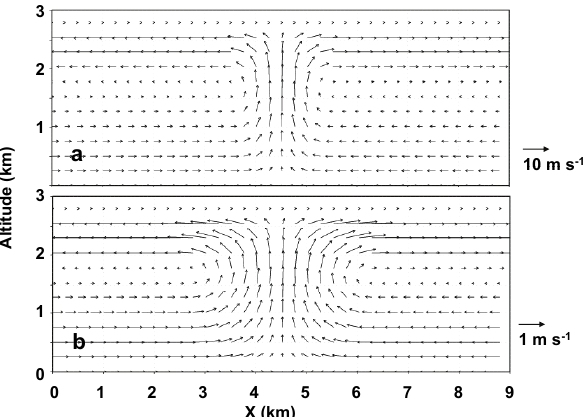
(km)0 9 X X (km) Fig. 3. The wind field at the time of peak updraft velocity for the shallow convective cloud case (a) at 15min and for the stratiform case (b) at 90min). Table 1. Number concentrations (cm − 3 ) of seeding particles un- der the cloud base in 20 cases including five different radii and four different total amounts of seeding particles. The reference total amount of seeding particles (ratio =1) is 2.83 × 10 − 4 gm − 3 . Fig. 4. Size distributions of the background CCN (red line), salt micro-powder (green line), and hygroscopic flare particles (blue line). Total number concentration of background CCN ( r> 0.01µm) is 1000cm − 3 . Those of seeding particles shown by size distribu- tions in green and blue are 90cm − 3 and 970cm − 3 , respectively. Maritime background CCN, which was used in preliminary numer- ical experiments, is also shown in this figure. The total number con- centration of maritime background CCN ( r> 0.01µm) is 140cm − 3